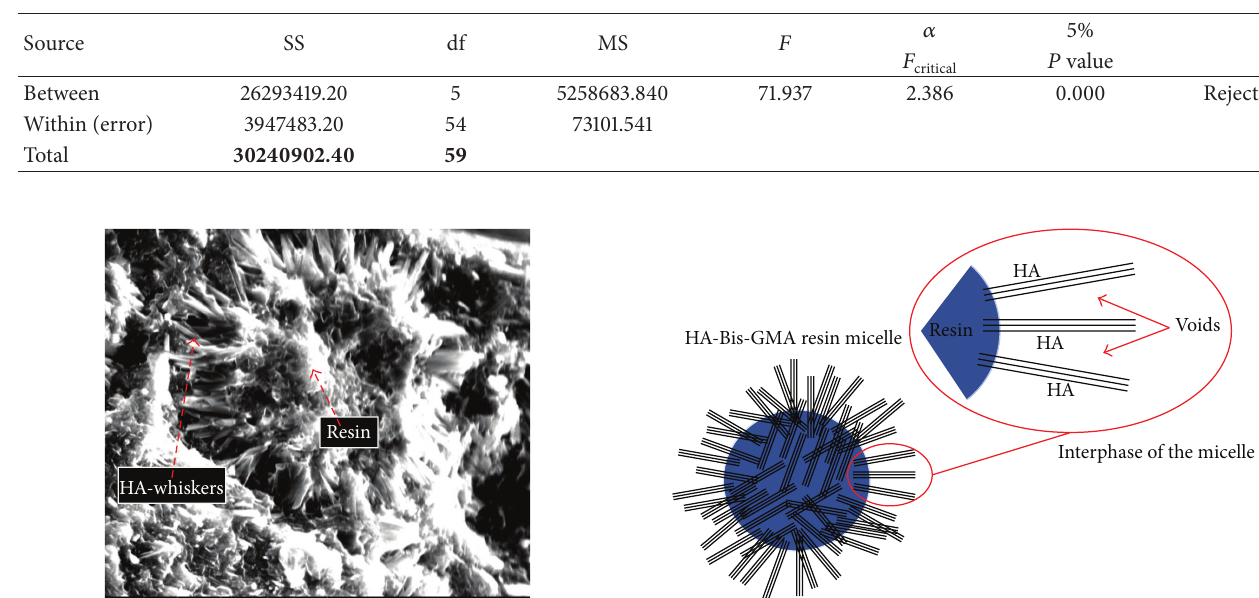
Table 4: Statistically significant differences on flexural modulus values were evaluated by one-way ANOVA, 𝑃 < 0.05 .